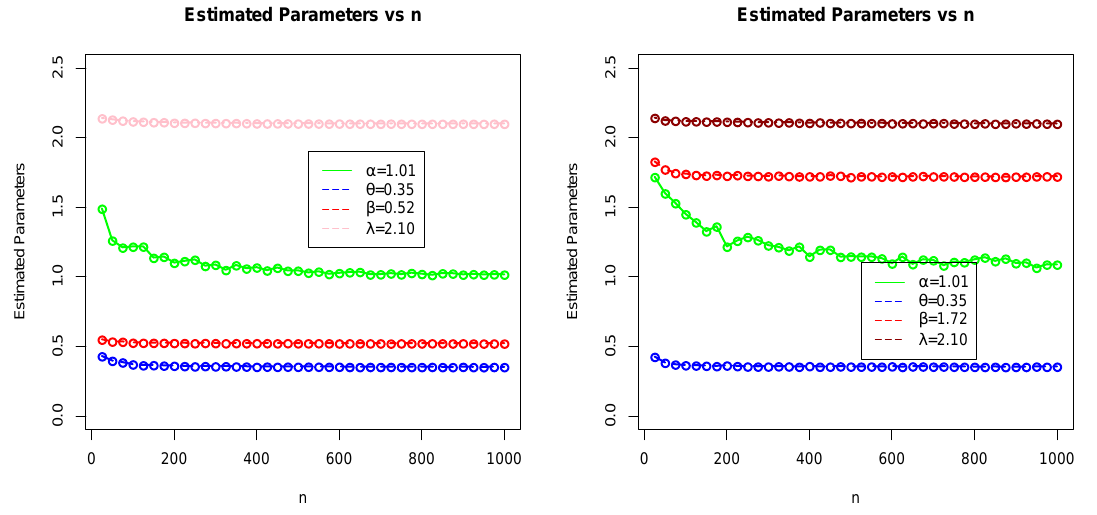
Figure 3. Plots of MLEs of the GAEPPRD for Set 1: α = 1.01, θ = 0.35, β = 0.52, λ = 2.10 and Set 2: α = 1.01, θ = 0.35, β = 1.72, λ =